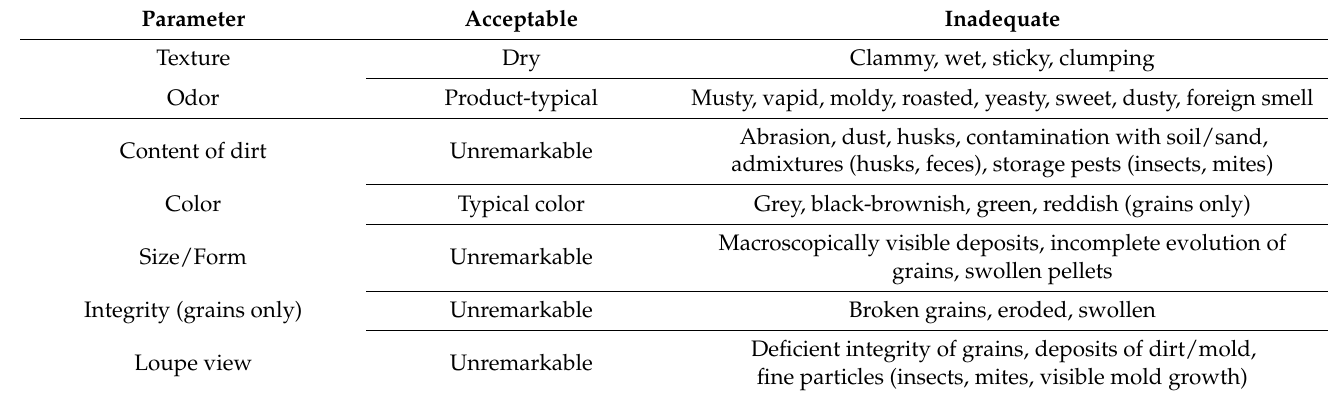
Table 1. Sensory analysis of grains and mixed feeds according to Kamphues